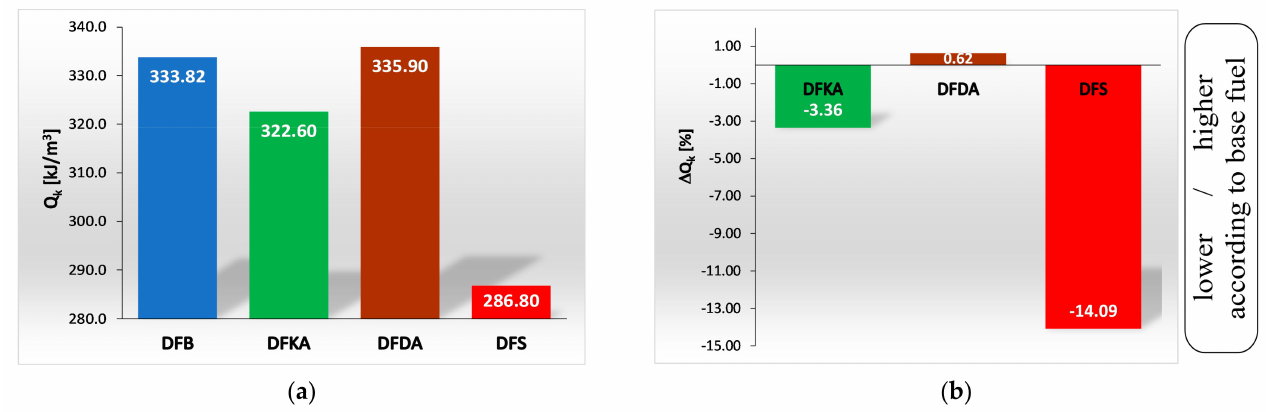
Figure 21. ( a ) Heat of kinetic phase (Q k ) for tested fuels. ( b ) Percent change in heat of kinetic phase ( ∆ Q k ) for tested fuels relative to Q k for DFB (base